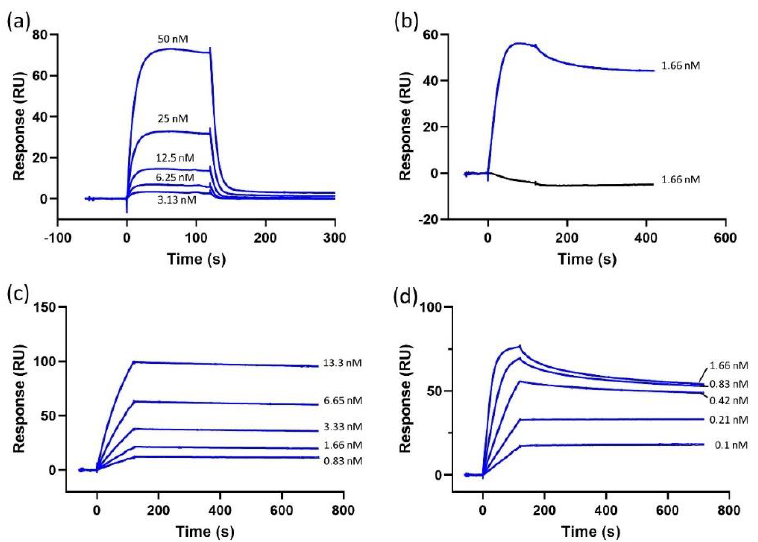
Figure 2. Sensorgrams depicting ( a ) CXCL12 (50, 25, 12.5, 6.25 and 3.13 nM) dose-dependent binding to histidine-tagged CXCR4 immobilized on a nitrilotriacetic acid (NTA) chip surface. ( b ) 12G5 mAb (1.66 nM) binding to histidine-tagged CXCR4 solubilized in regular solubilization buffer (blue) and the solubilization buffer with Triton X-100 (black). ( c ) 1D9 mAb (13.3, 6.65, 3.33, 1.66 and 0.83 nM) dose-dependent binding to CXCR4. ( d ) 12G5 mAb (1.66, 0.83, 0.42, 0.21 and 0.1 nM) dose-dependent binding to CXCR4.